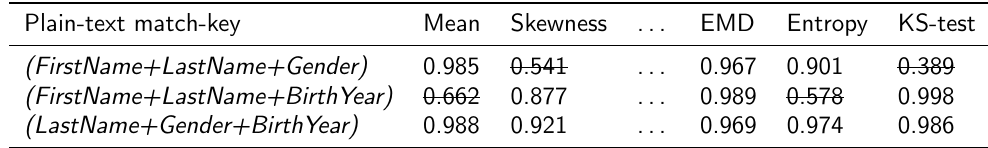
Table 2: An example correlation matrix C for the encoded match-key ( LastName+Gender+BirthYear ) after the filtering process discussed in the third step of the attack. Crossed-out values represent the plain-text match-keys that are not selected for the corresponding metric due to their low